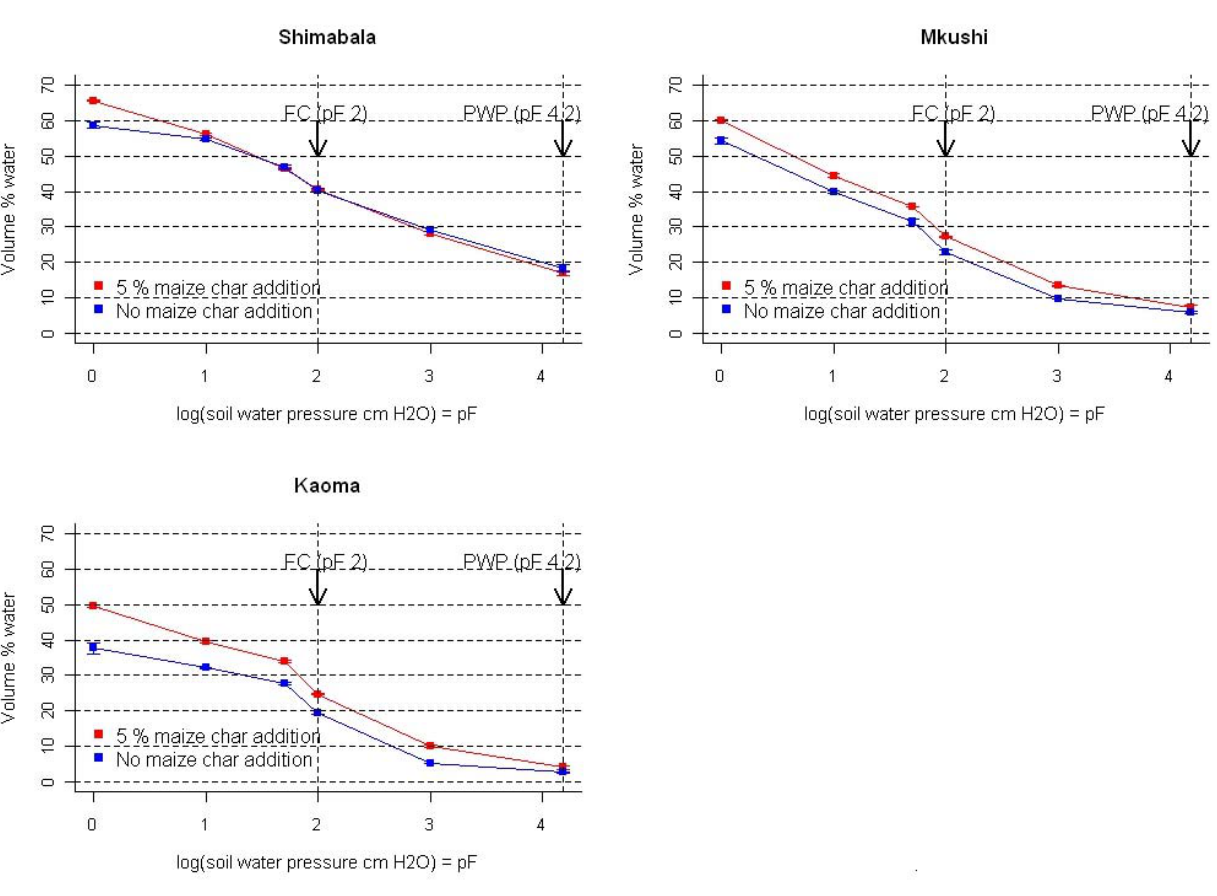
Figure 2. Soil moisture retention (pF curves) of soils without biochar (blue) and with 5% biochar (red) (Shimabala, Kaoma, Mkushi as examples), plant available water is between pF 2 (field capacity) and pF 4.2 (wilting point). FC is field capacity, PWP is permanent wilting point. Error bars represent standard deviations of triplicate